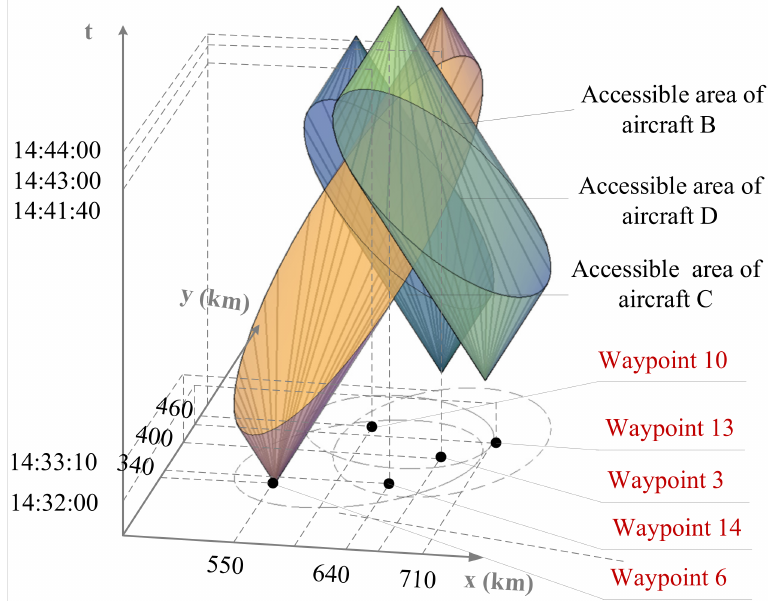
Figure 10. Schematic of aircraft conflict among aircraft B, C, and D.